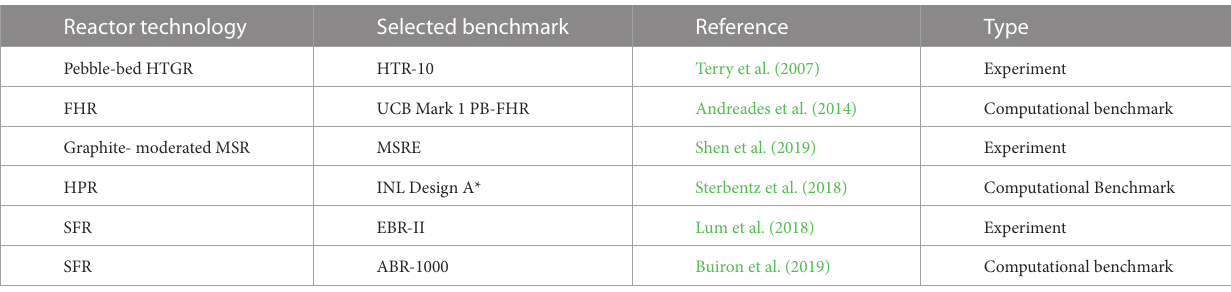
TABLE1 Overviewofselectedadvancedreactortechnologybenchmarks.